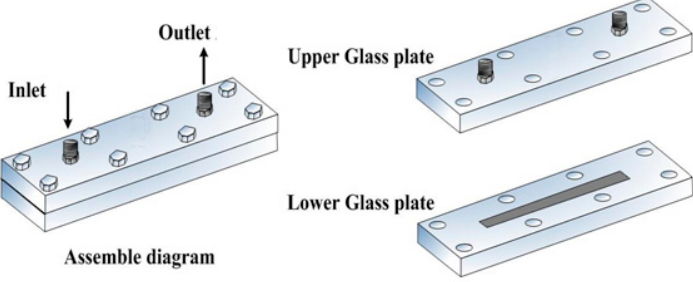
Figure 2. Schematic diagram of transparent asymmetric plate-type micro-channels (TAPMs).